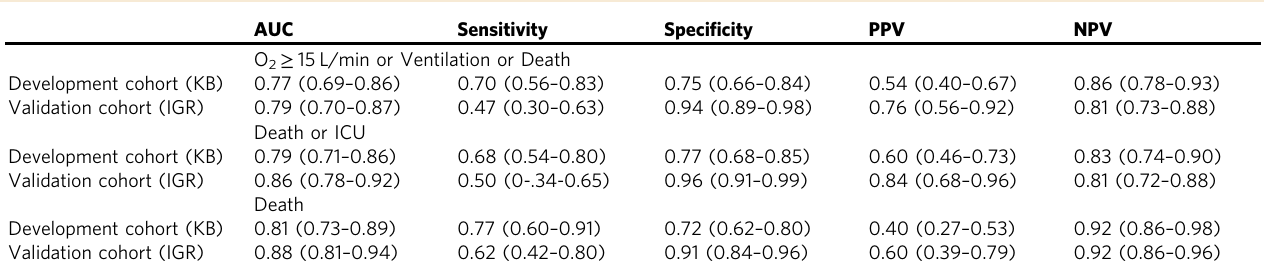
Table 2 Statistical measures of the performance of